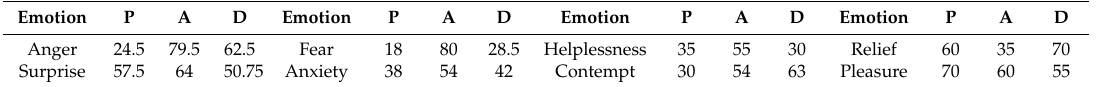
Table 8. Converted coordinates of each emotion.